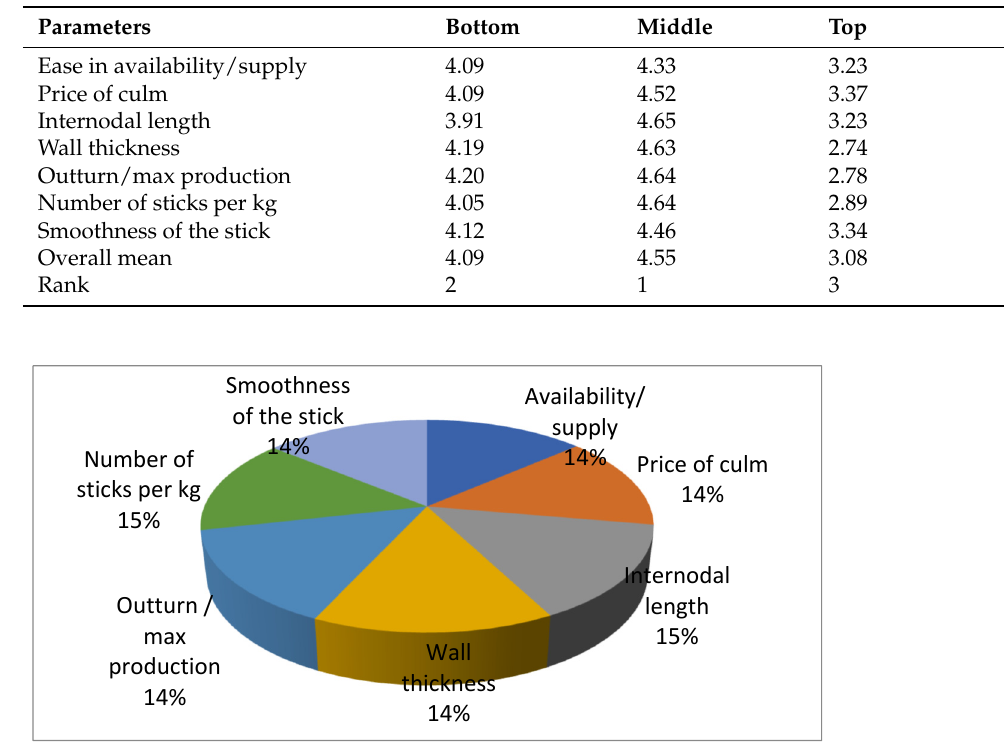
Figure 3. Percent contribution of different attributes for the choice of portion of culm for the incense stick industry.